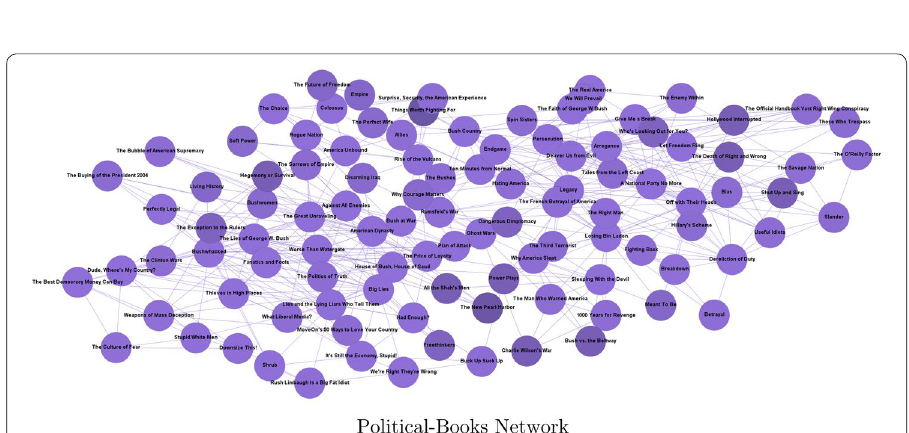
Fig. 3 Political-books network dataset with ground-truth communities. A simple example of Political books ground-truth network